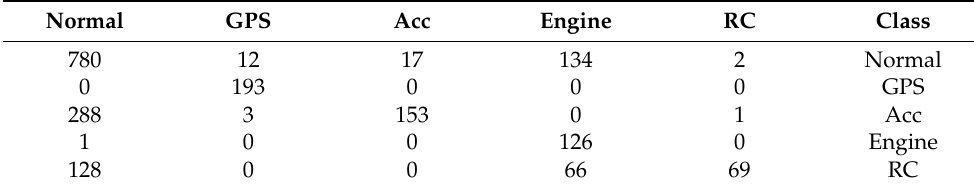
Table 12. Confusion matrix of Naive Bayes algorithm.